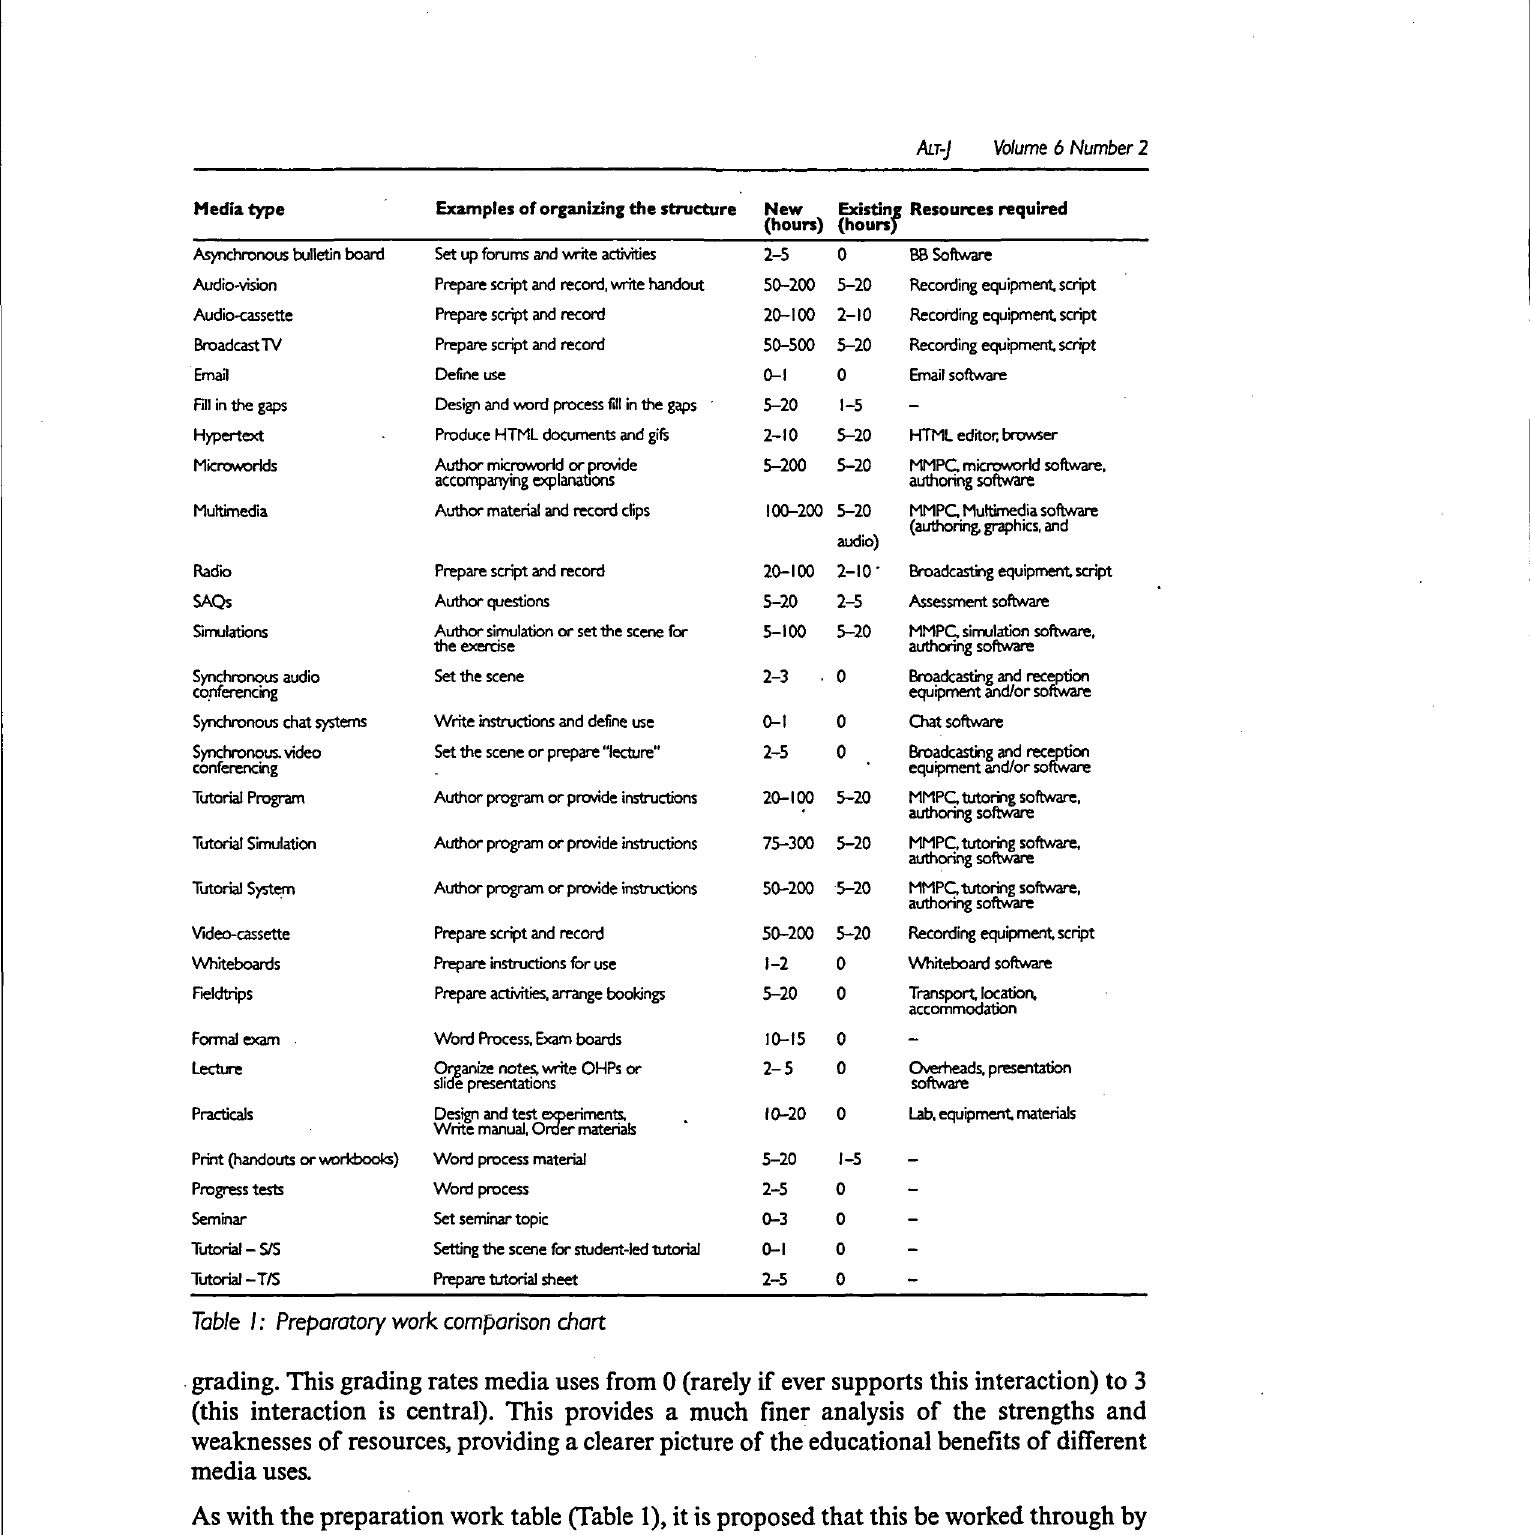
Table I: Preparatory work comparison chart grading. This grading rates media uses from 0 (rarely if ever supports this interaction) to 3 (this interaction is central). This provides a much finer analysis of the strengths and weaknesses of resources, providing a clearer picture of the educational benefits of different media